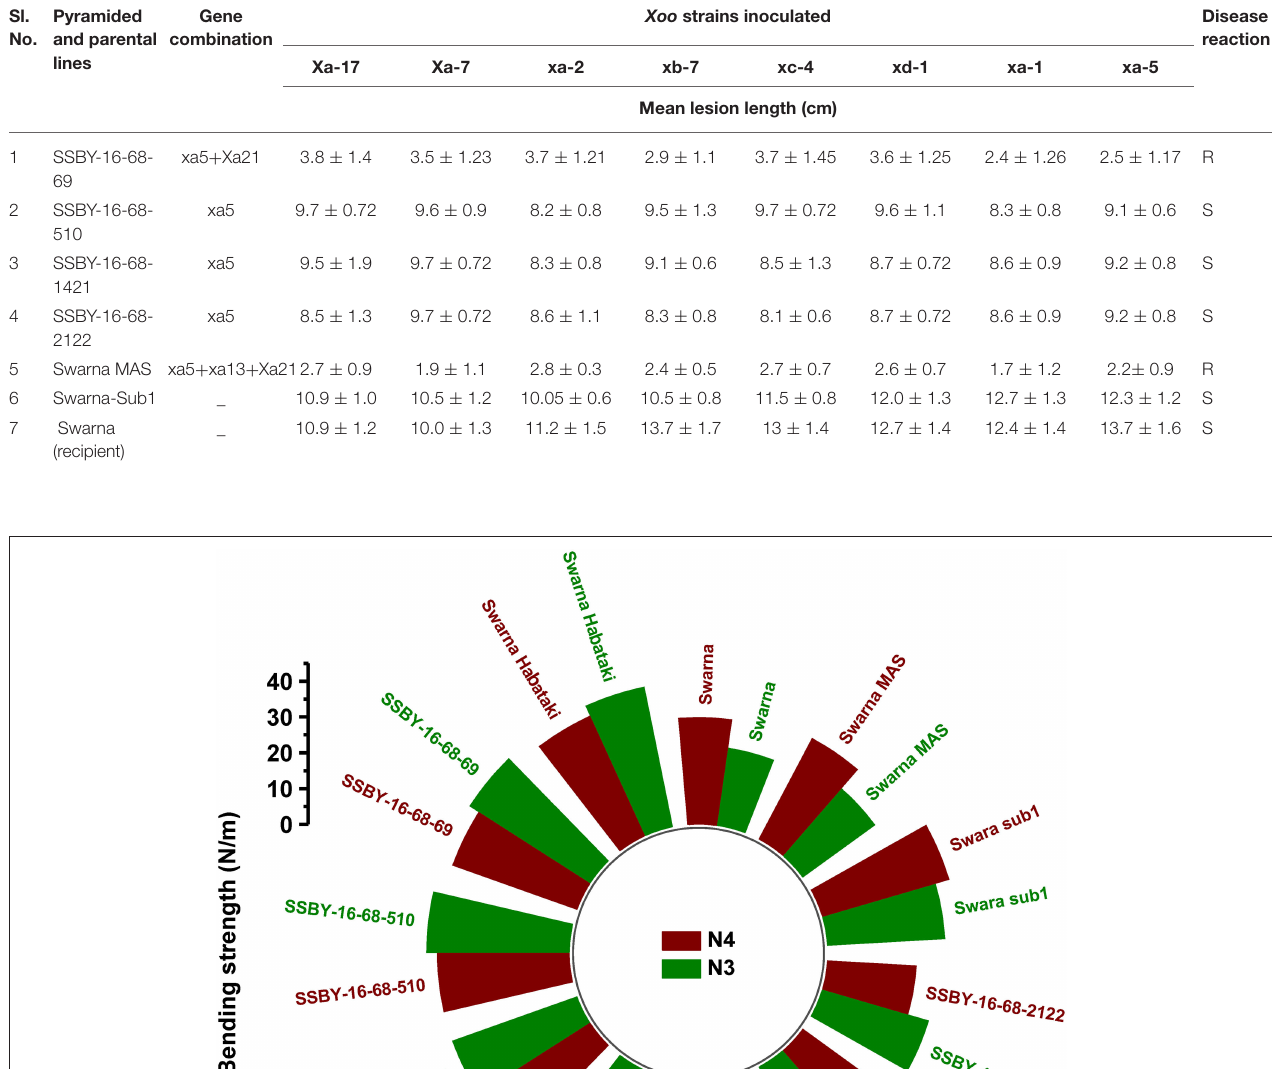
Xoo strains inoculated Disease